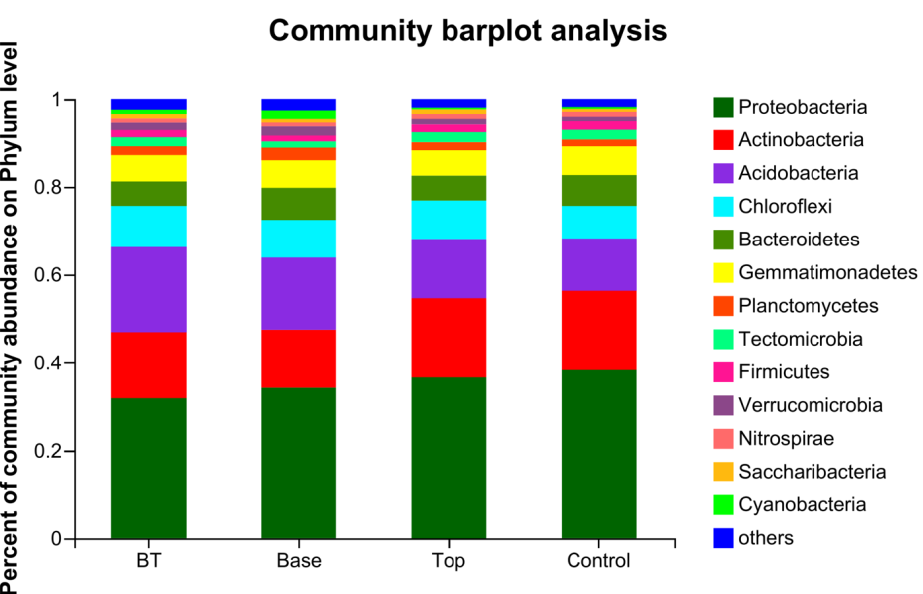
Figure 2. Composition of bacterial communities at the phylum level in three treatments and the control. BT, combined base fertilizer and topdressing fertilizer; Top, topdressing fertilizer; Base, base fertilizer; Control, no fertilizer.